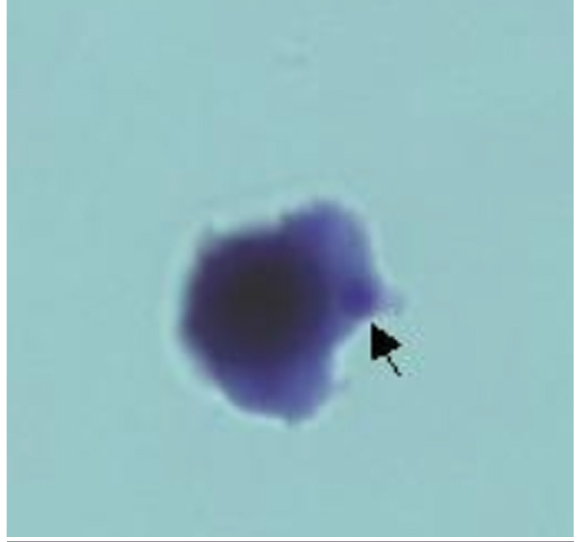
Figure 2. Polychromatic erythrocyte with micronucleus (arrow) in an animal exposed to Ca 1000x